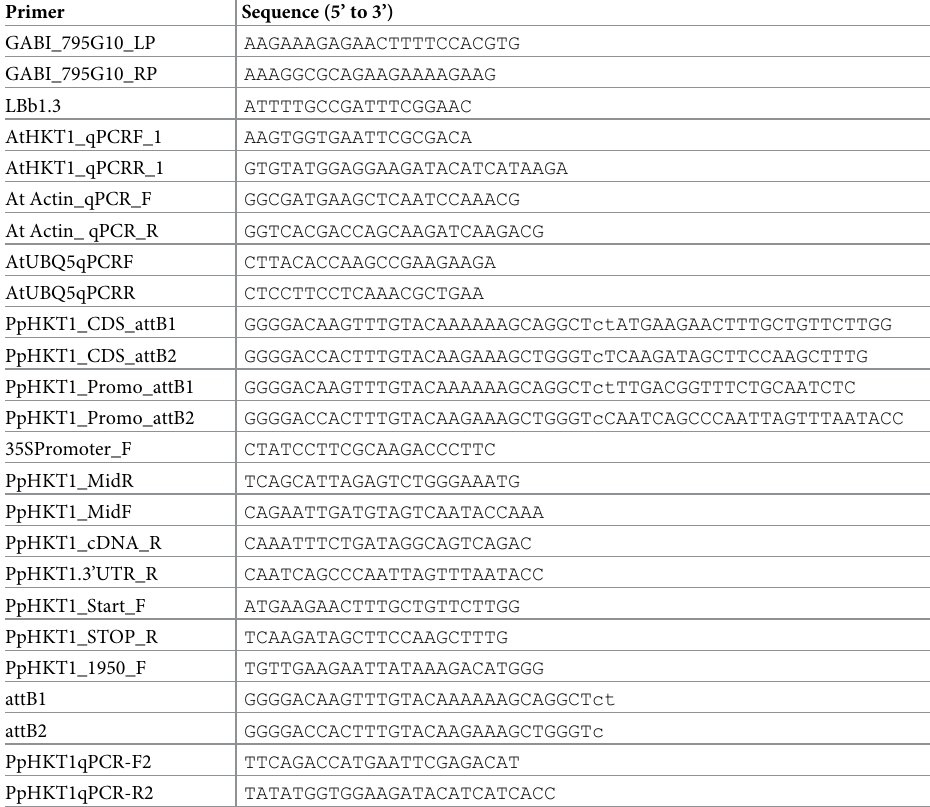
Table 1. The list of primers used in the study.